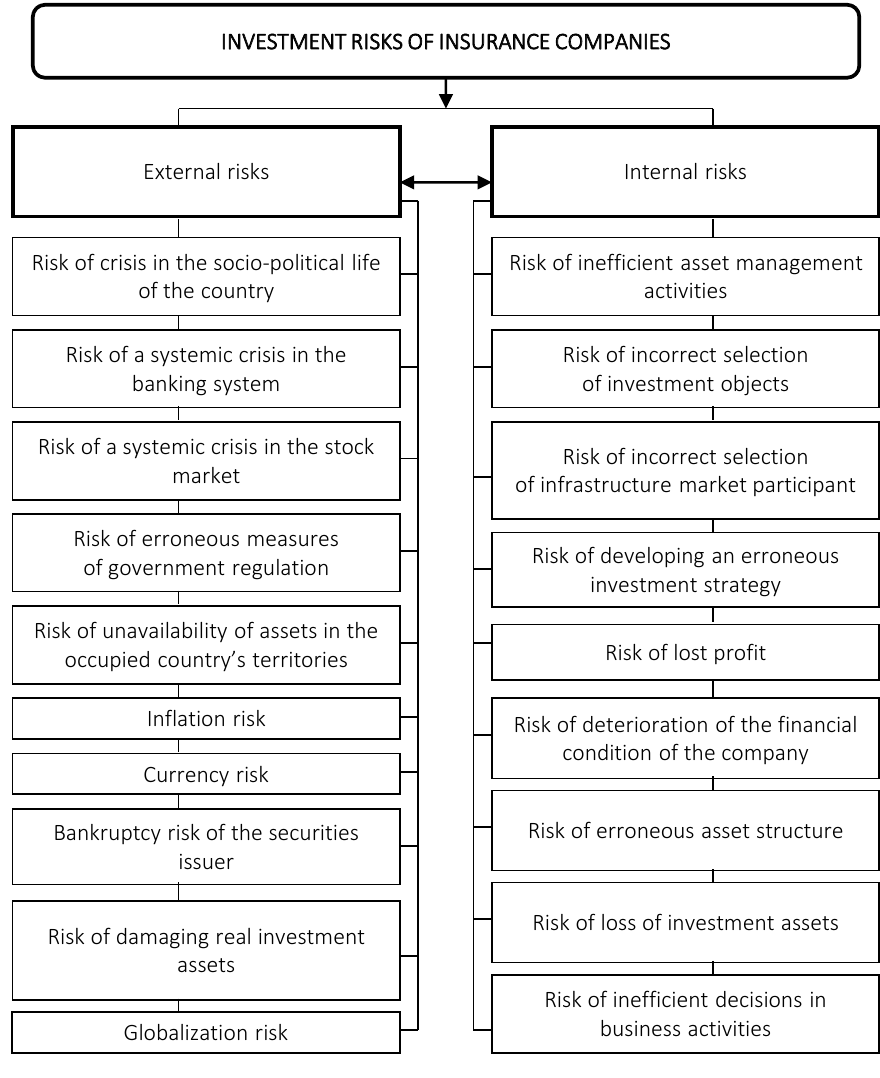
Figure 2. List of risks of IC investment